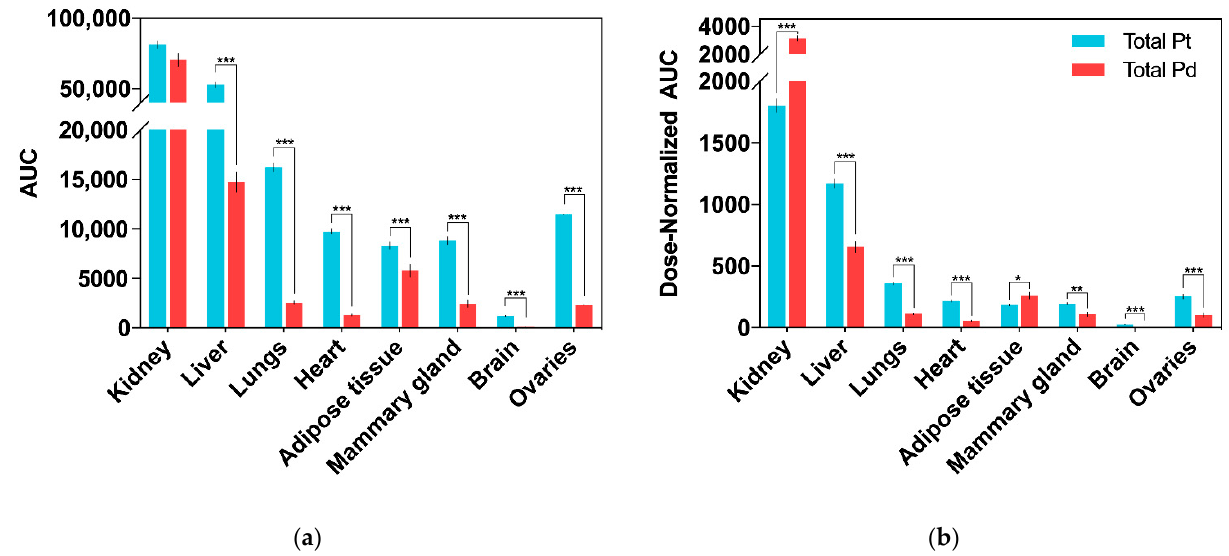
Figure 4. Biodistribution of total Pd (from Pd 2 Spm, 3 mg/kg bw) and Pt (from cisplatin, 3.5 mg/kg bw) in tissues after single intraperitoneal bolus injection in Balb/c mice. Data are expressed as mean ± SEM ( n = 5 animals per time point) and were compared with Student’s t -test. * p < 0.05, ** p < 0.01, *** p < 0.001. ( a ) AUC 0-48h (area under the Pd/Pt concentration–time curve). Units: h × ng/g of tissue; ( b ) dose-normalized AUC 0–48 h (area under the Pd/Pt concentration–time curve). Units: h × ng/g per µg metal dose.